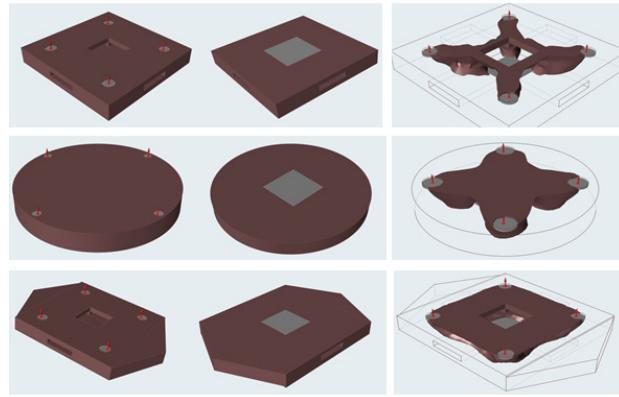
Figure 2. Iterations for considering initial geometry. Table 1. Material properties of ABS.